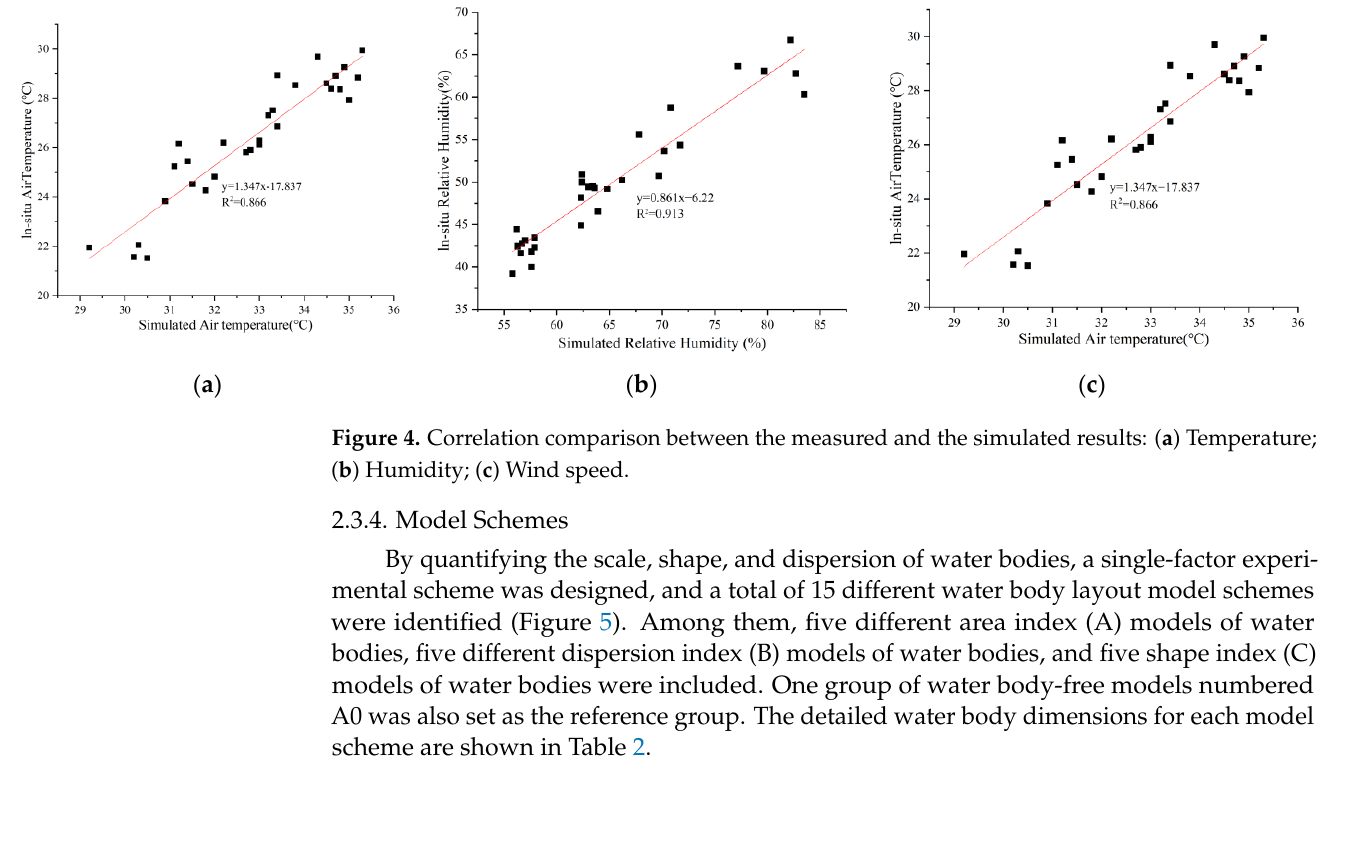
Figure 3. Theoretical model of the campus square: ( a )with-tree model; ( b )without-tree model.